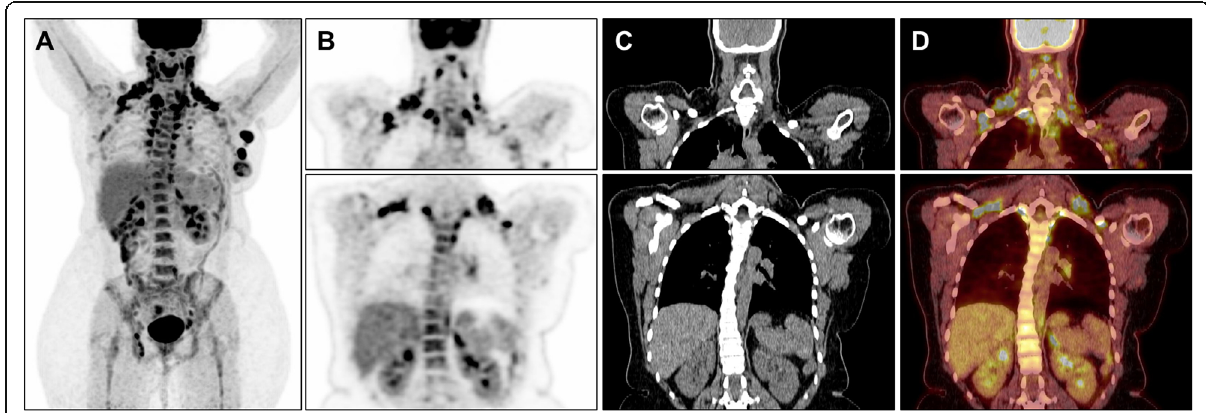
Fig. 3 Brown fat uptake: 18 F-FDG PET/CT scan of a 41-year-old female with HER2 overexpression left breast cancer: a maximum intensity projection and b coronal PET show intense 18 F-FDG uptake in the cervical, supraclavicular, paravertebral, and perinephric regions. c The corresponding CT and d coronal PET/CT fusion images reveal that 18 F-FDG uptake is corresponding to the fatty tissue and there is no abnormal lymph node or muscle uptake, denoting activated BAT